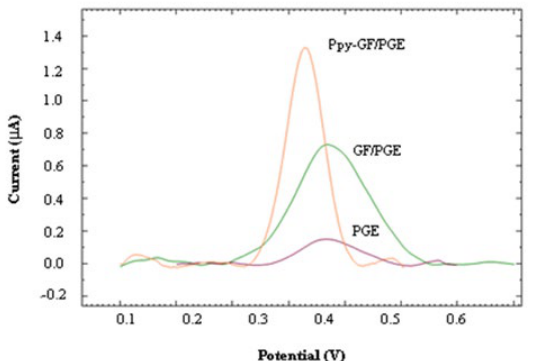
Fig. 3 . Differential pulse voltammogram of 0.695µM of insulin in BRBS (pH=11) and KCl (0.2 M) at PGE, modified GF/PGE and Ppy-GF/PGE (pulse amplitude: 0.1-1V; scan rate: 50 mV s -1 ; pulse time: 25 s)